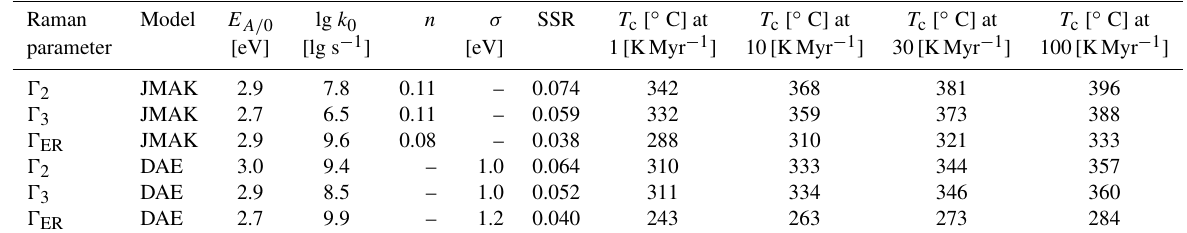
Table 1. Parameter estimates for the Johnson–Mehl–Avrami–Kolmogorov (JMAK) and distributed activation energy (DAE) annealing mod- els and calculated closure temperatures T c for cooling rates of 1, 10, 30, and 100KMyr − 1 .